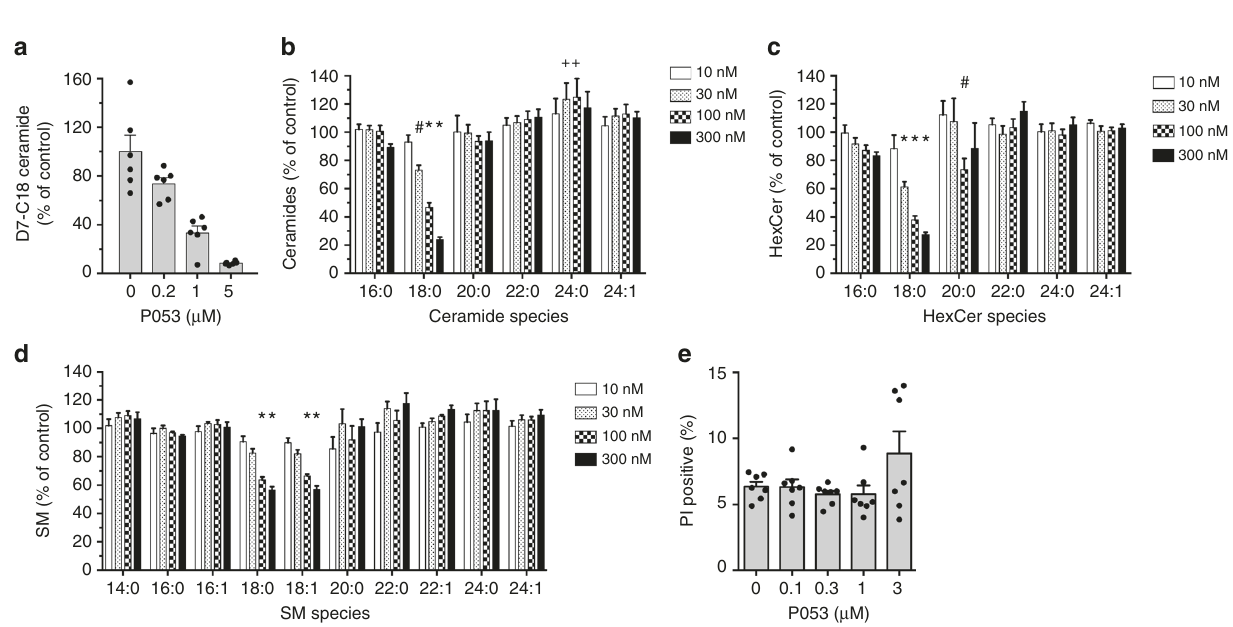
Fig. 2 P053 selectively reduces C18 sphingolipids in cultured cells. a Formation of deuterated ceramide from deuterated (D7) dihydrosphingosine in cortical neuron cultures pre-treated for 2 h with P053. b – d Endogenous ceramide ( b ), HexCer ( c ), and SM ( d ) levels in HEK293 cells treated for 24 h with P053 at concentrations indicated on the graphs. Lipid levels are expressed as a percentage of vehicle control levels. Absolute lipid levels are shown in Supplementary Figure 1, with raw data for these images provided in Supplementary Data File 1. e Percentage of non-viable HEK293 cells determined by propidium iodide (PI) staining and fl ow cytometry, following a 72 h treatment with P053. All graphs show combined data from two